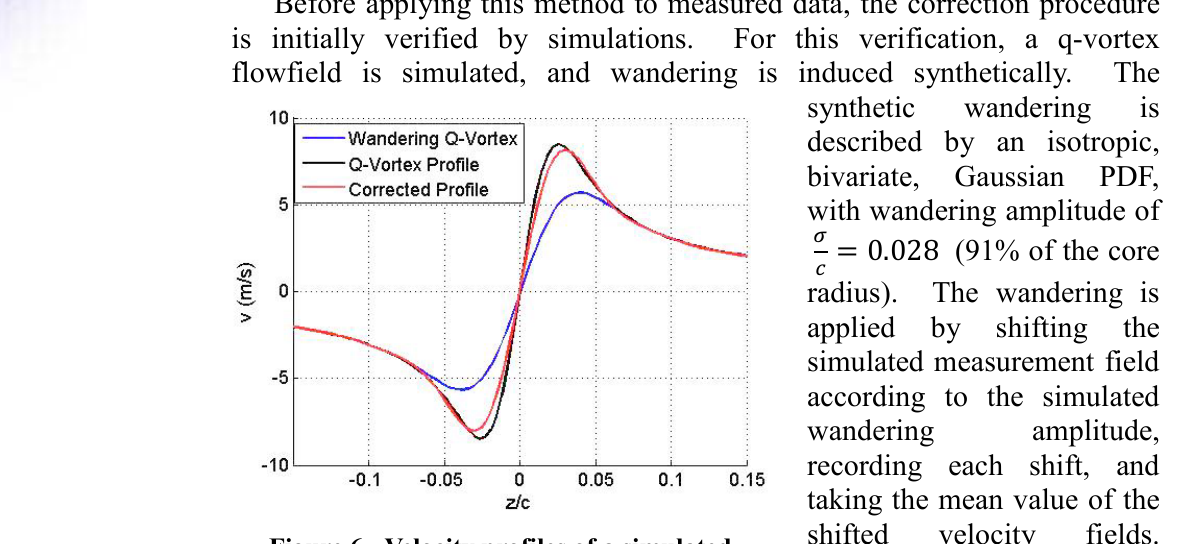
Figure 6 - Velocity profiles of a simulated Q-vortex with synthetic wandering, a Q-vortex without wandering, and the profile resulting in the deconvolution correction method. The synthetic wandering amplitude is (cid:2252) (cid:2185)⁄ (cid:3404) (cid:2777). (cid:2777)(cid:2779)(cid:2785) and the standard deviation of the added noise is (cid:2252) (cid:3404) (cid:2777). (cid:2777)(cid:2778) (cid:1813) (cid:1819)⁄ (cid:2196)